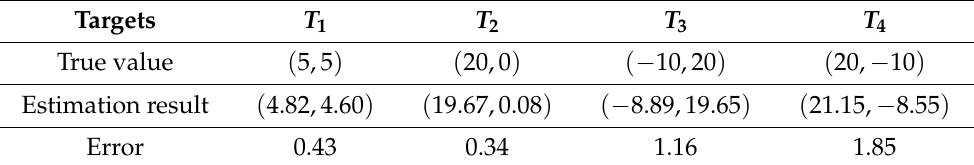
Table 2. The results using the independent estimation approach.